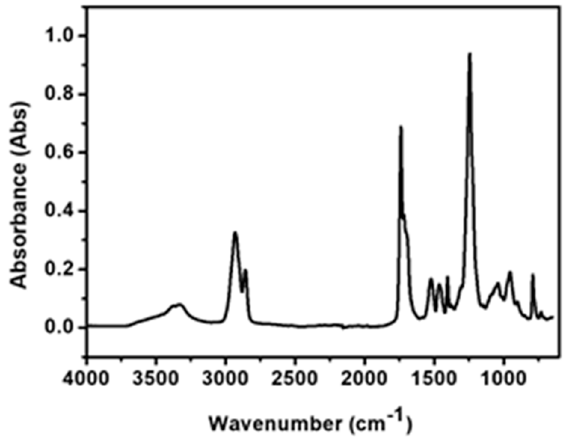
Figure 4. FTIR spectra of stainless steel wire after being coated with TPU.